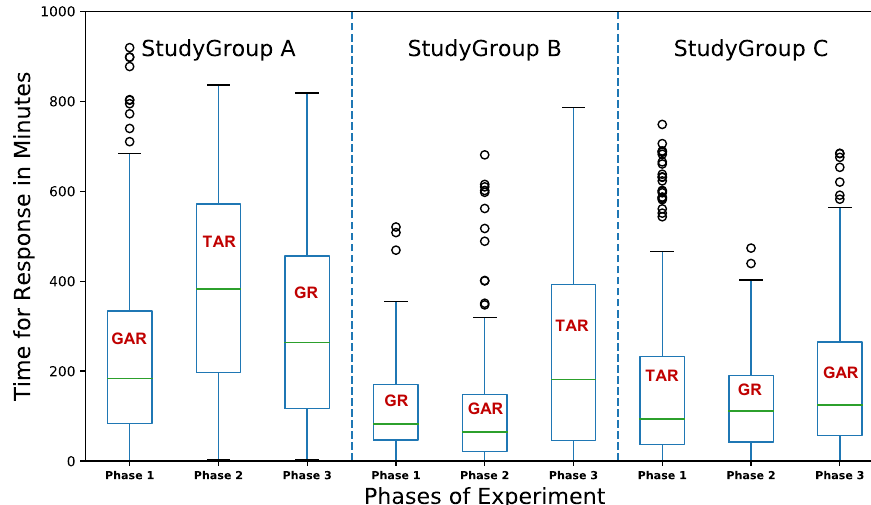
Figure 10. Total number of reports received.